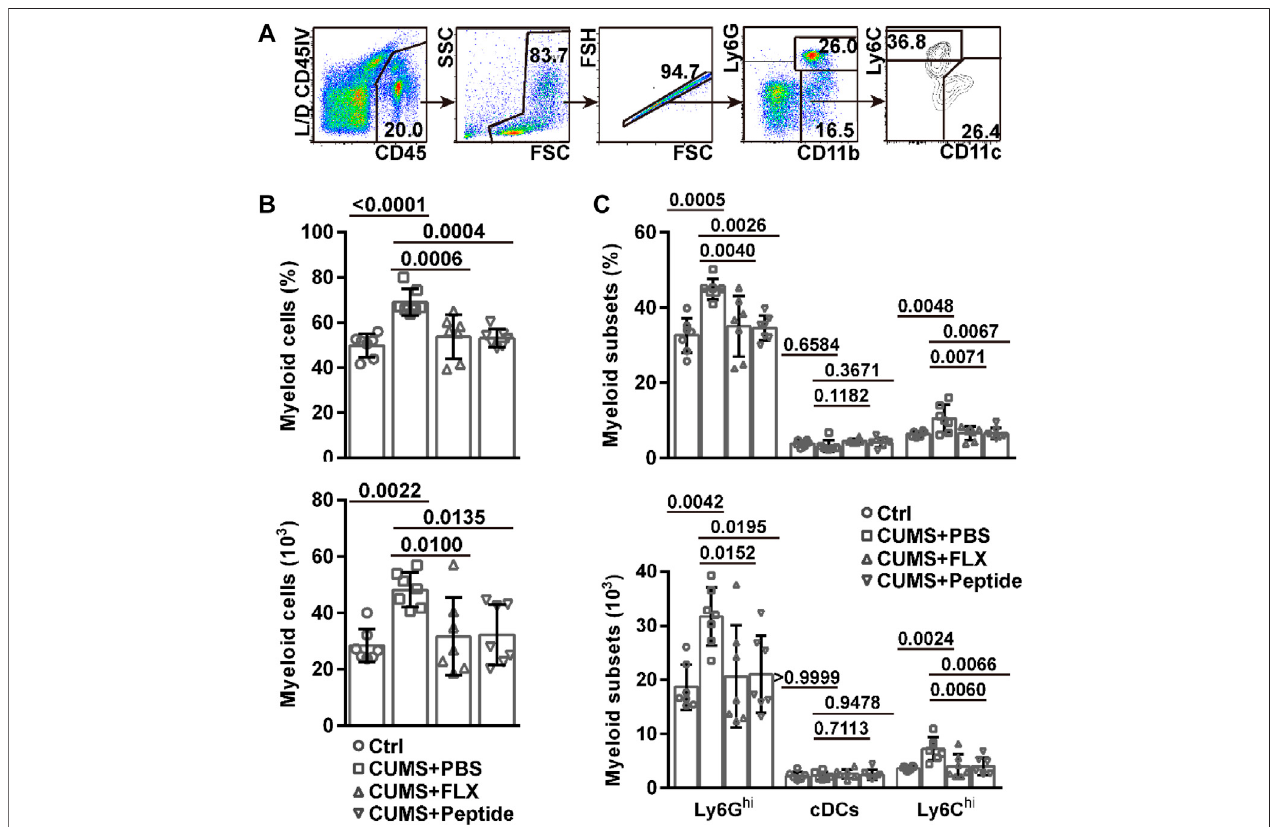
FIGURE4| ARA290exhibitedsimilar effectsto fl uoxetineonmeningealmyeloidcellsintheCUMSmousemodel:8-week-oldmaleC57BL/6 micesubjectedtothe CUMSmodel( n =7micepergroup)weretreatedwith fl uoxetine(FLX)orARA290(peptide)daily.Then,mechanicallyisolatedduracellsweresubjectedto fl owcytometry analysis of myeloid cells. (A) representative gating strategy. (B) the frequency of CD11b + myeloid cells in CD45 + leukocytes and their number in the cranial dura. (C) the frequencyofCD11b + CD11c − Ly6G hi neutrophils,CD11b + CD11c − Ly6C hi monocytes,andCD11b + CD11c + conventionaldendriticcells(cDCs)inCD45 + leukocytes and their number in the cranial dura. The statistical values between different groups are